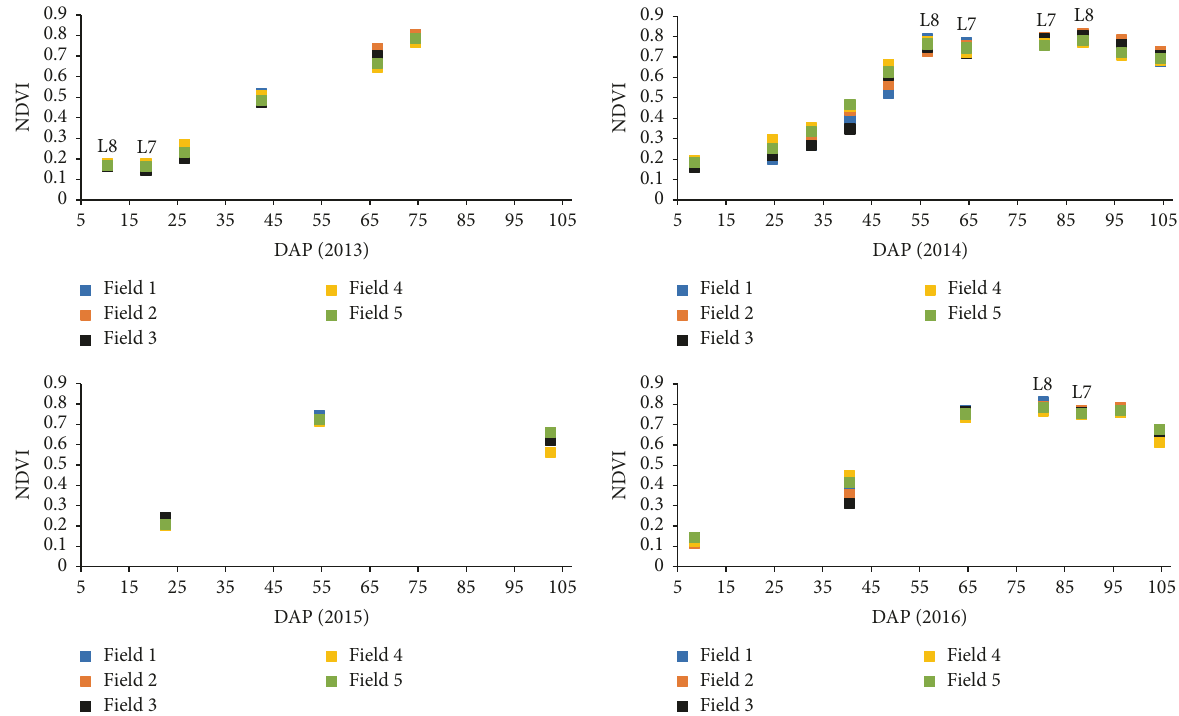
Figure 3: Seasonal evolution of NDVI at five corn fields for 2013, 2014, 2015, and 2016 growing seasons in northern Mexico.